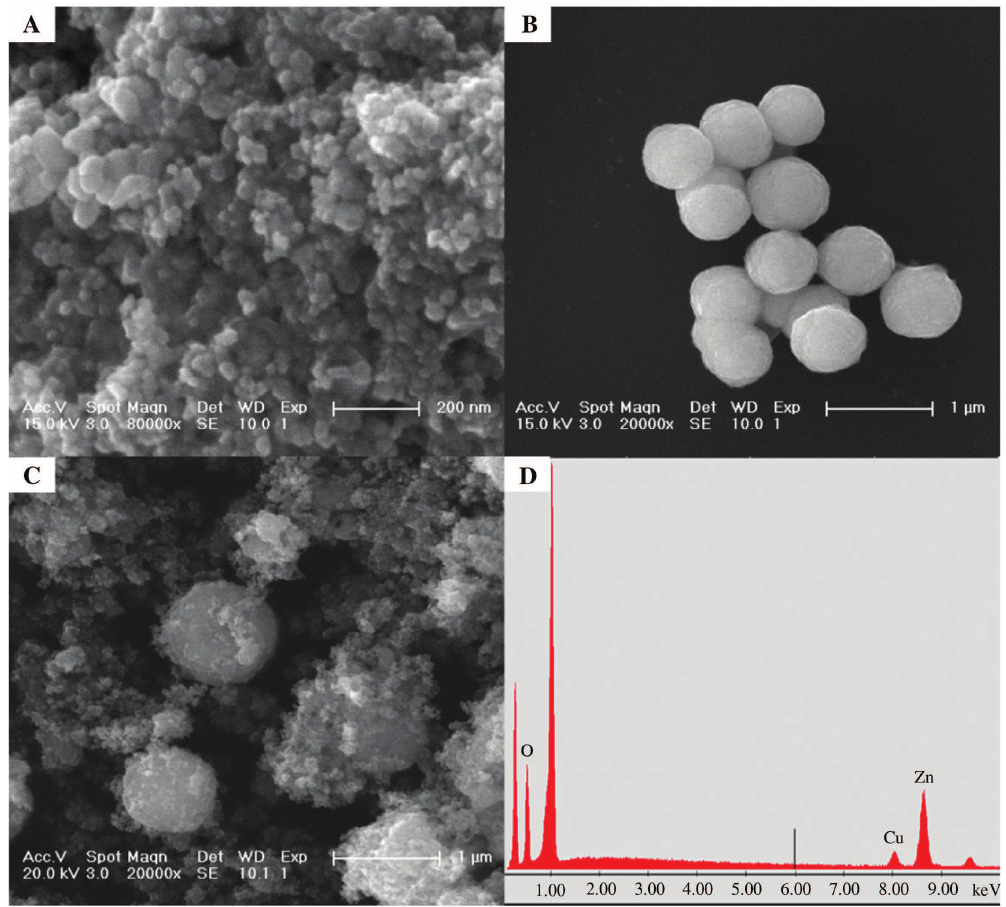
Figure 2: SEM images of ZnO (A), Cu 2 O (B), and Cu 2 O/ZnO (sample II; C) and EDX of Cu 2 O/ZnO (sample II;